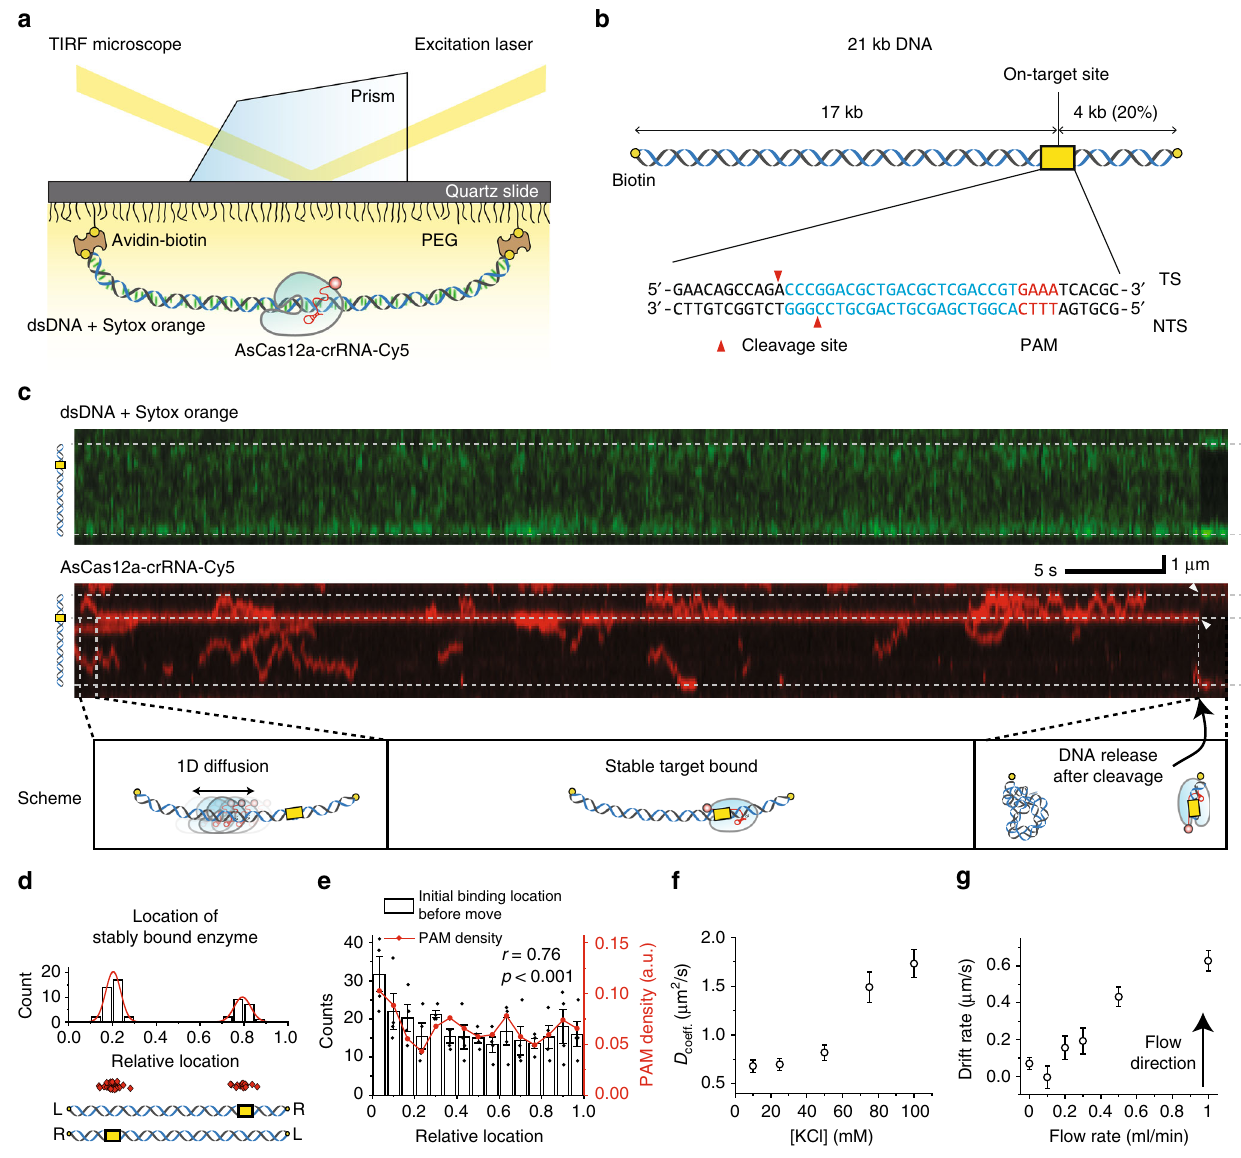
Fig. 1 Real-time observation of AsCas12a RNP undergoing 1D diffusion for target searching. a Schematic representation of the TIRF microscope setup and the experimental design. b Diagram of the 21 kb DNA molecule containing biotins at both ends for immobilization. The AsCas12a – crRNA complex target site is located at a position that is 20% along the length of the DNA. DNA sequences around the target site are shown below. c Kymograph of dsDNA (visualized with Sytox orange) and AsCas12a localization (visualized with crRNA-Cy5) over time ( x axis). d Position distribution of AsCas12a stably bound to the target. Two possible orientations of DNA containing the target site are shown below. ( n P54; number of analyzed molecules). e The distribution of AsCas12a 1D diffusion start sites along the DNA (white bars) and the probability density of PAM sequences in a 21 kb DNA molecule (red line). The DNA orientation was determined by the location of a stably bound AsCas12a molecule. The degree of correlation between the two graphs was evaluated by Pearson ’ s correlation analysis ( r = 0.75, p < 0.001). Initial binding locations of AsCas12a were collected from at least four independent experiments (total number of data is 1054). f Ionic strength-dependent diffusion coef fi cients of AsCas12a RNP on the 21 kb DNA in the absence of external force. At least 191 molecules are analyzed for this graph from two independent experiments (236 for 10 mM; 233 for 25 mM; 291 for 50 mM; 191 for 75 mM; and 236 for 100 mM). g Flow rate versus drift rate of AsCas12a RNP on a single tethered λ -phage DNA. As the fl ow rate is increased, the AsCas12a RNP drift rate increases. At least 240 molecules are analyzed for this graph from two independent experiments (291 for 0 ml/min; 309 for 100 ml/min; 468 for 200 ml/min; 433 for 300 ml/min; 240 for 500 ml/min; and 248 for 1000 ml/min). The error bars in these fi gures mean the standard error of the